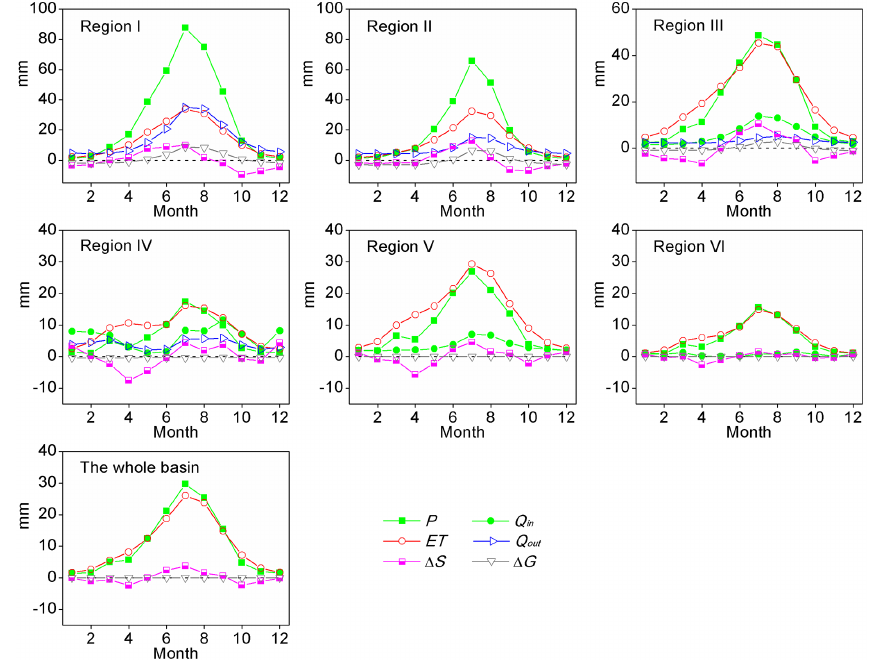
Figure 7. Variation of average monthly water balance for all regions using the abcd model. Table 3. The fitting parameters of Fu’s equation at annual scales. Region I II III Whole